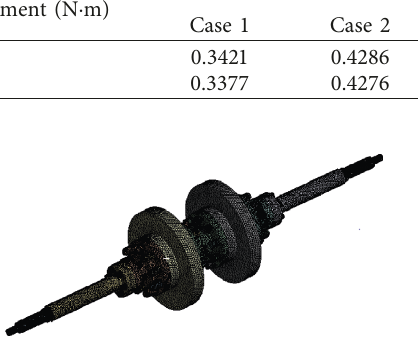
Figure 12: Three-dimensional finite element model of the experimental rod-fastened rotor.